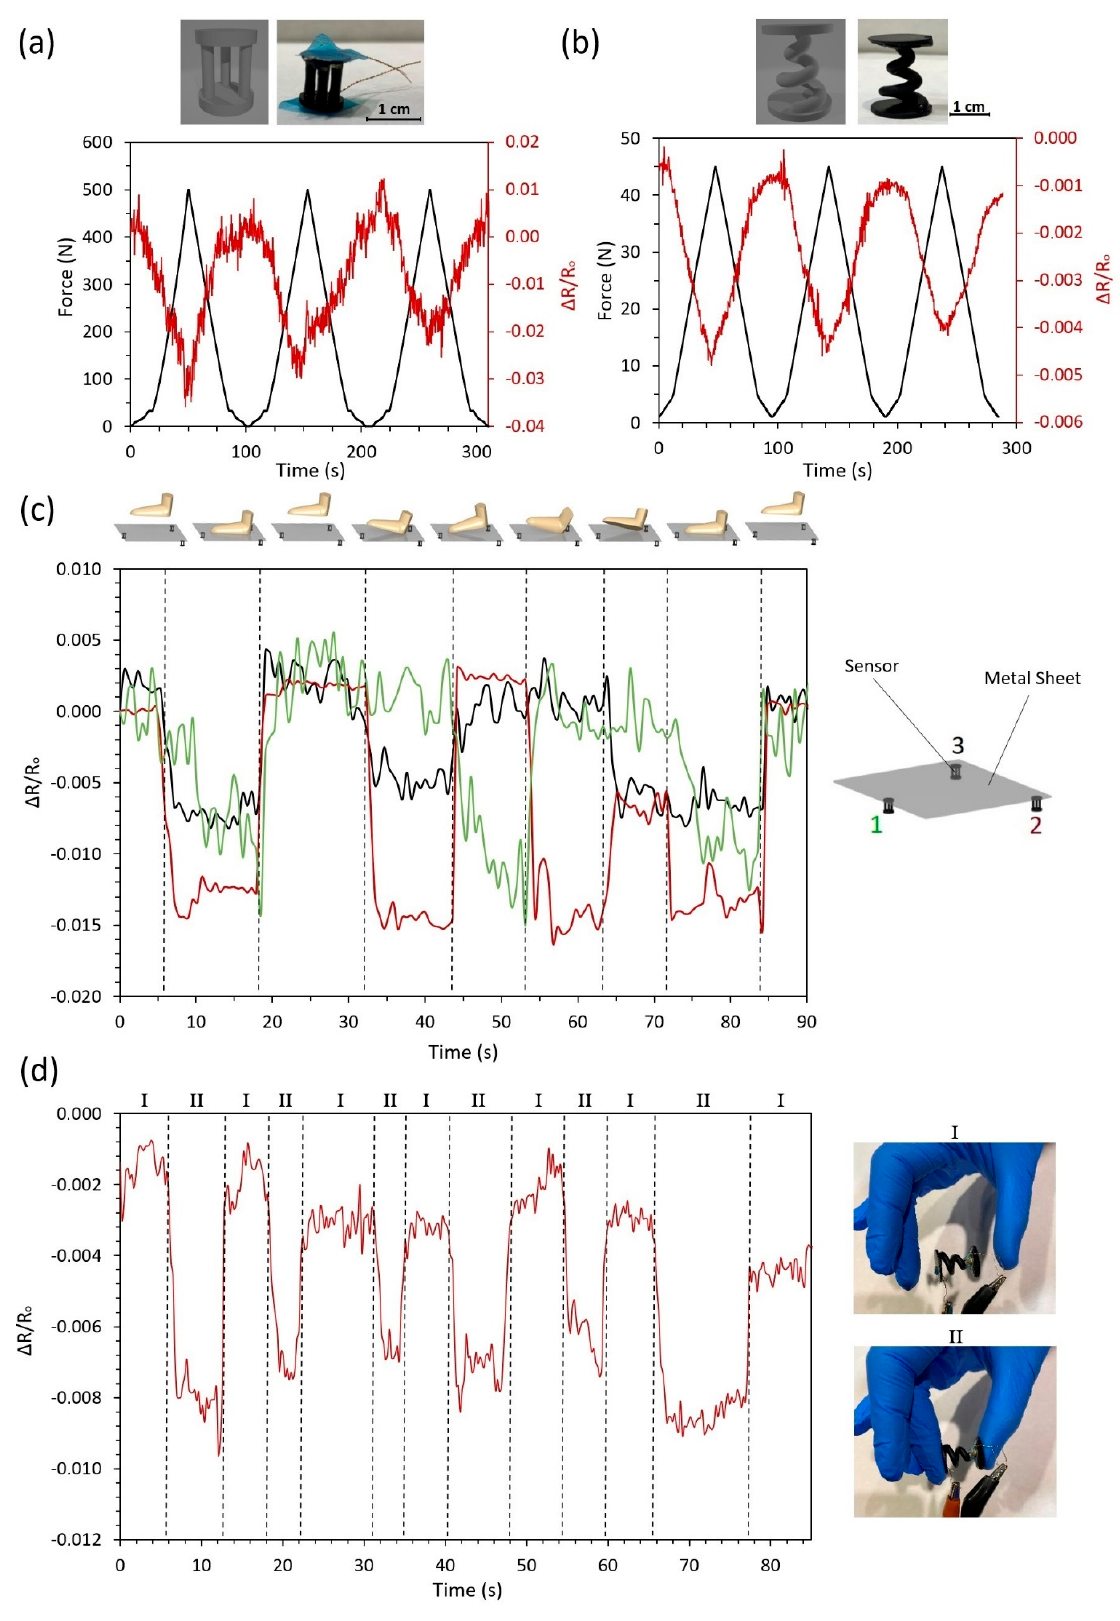
Figure 5. Self-sensing printed complex devices: ( a ) cycling compression load of the three-column device, ( b ) cycling compression load of the spring, ( c ) footstep platform and ( d ) manual compression of spring device.